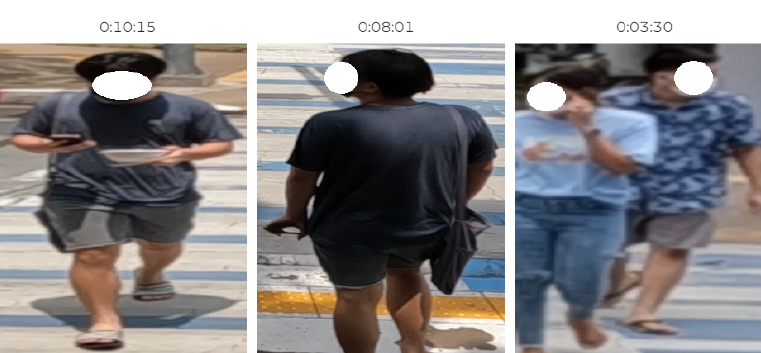
Figure 5. The top 3 search results for the query description (literal translation from Thai): “short sleeve grey t-shirt grey short grey pants sandals bag”. The top 2 matches are the correct person. The third match, while not the correct person, captures the “short grey pants” and “sandals”. Above the image of each person is the timestamp from the original video.